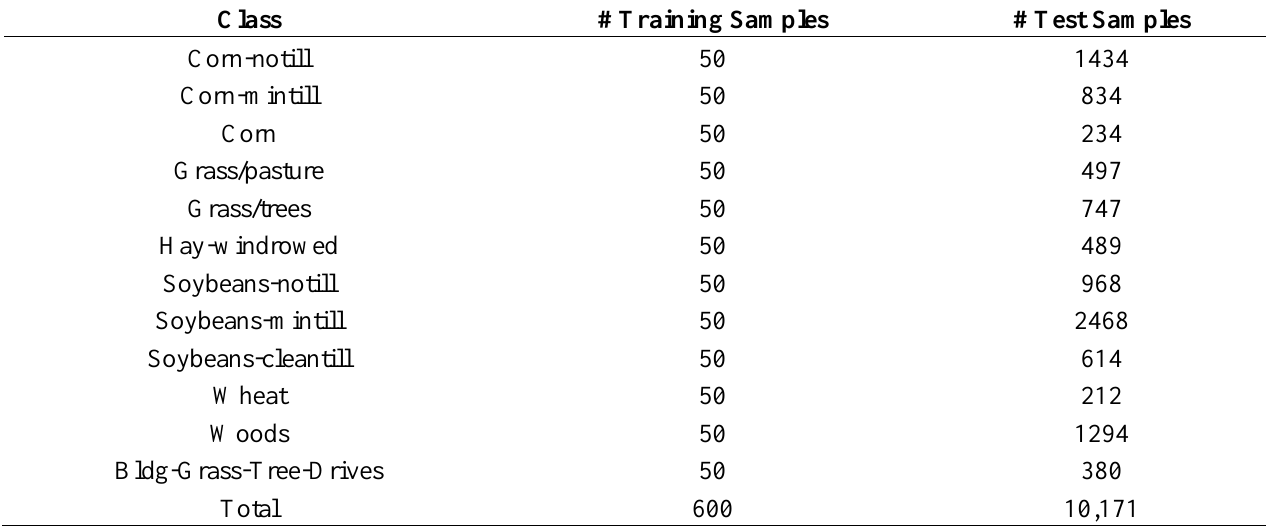
Table 1. Numbers of samples for the Indian Pines image.